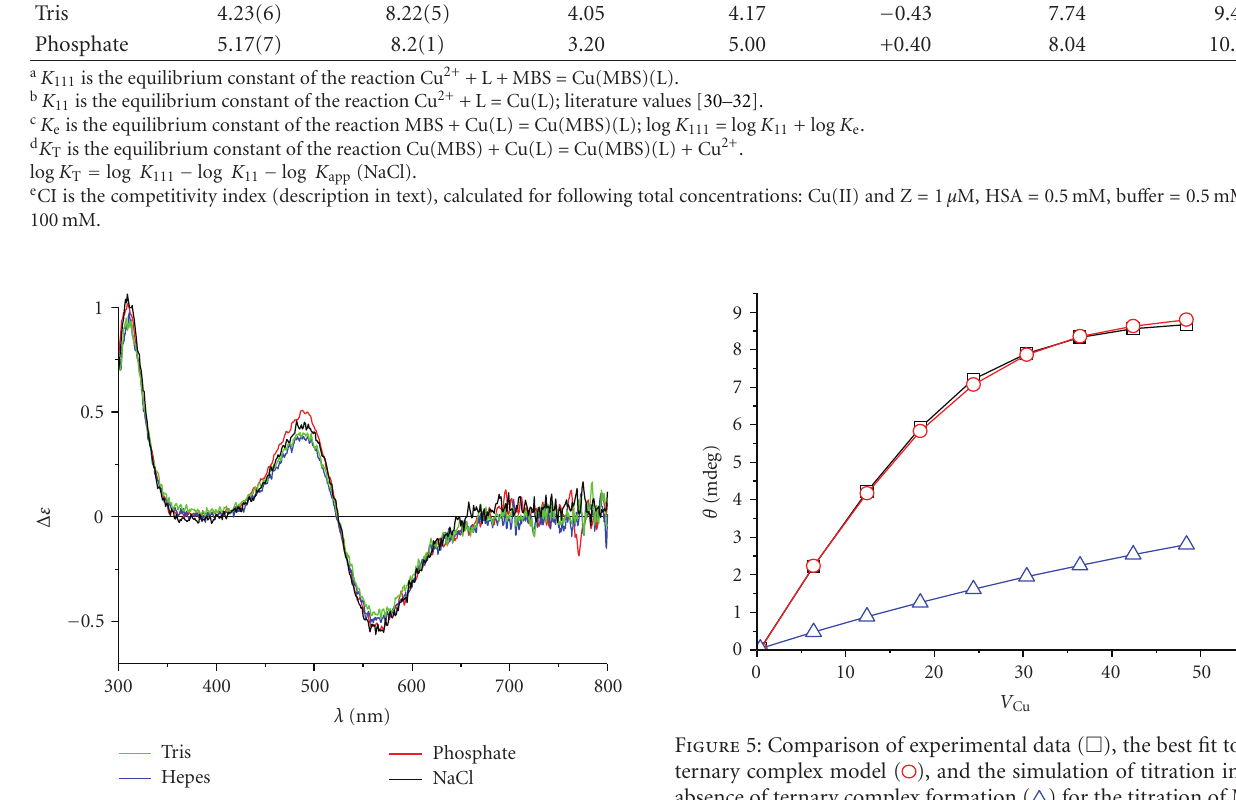
Figure 3: Spectra of pure forms of NTS-Cu(II) complexes obtained by extrapolation of titration data.